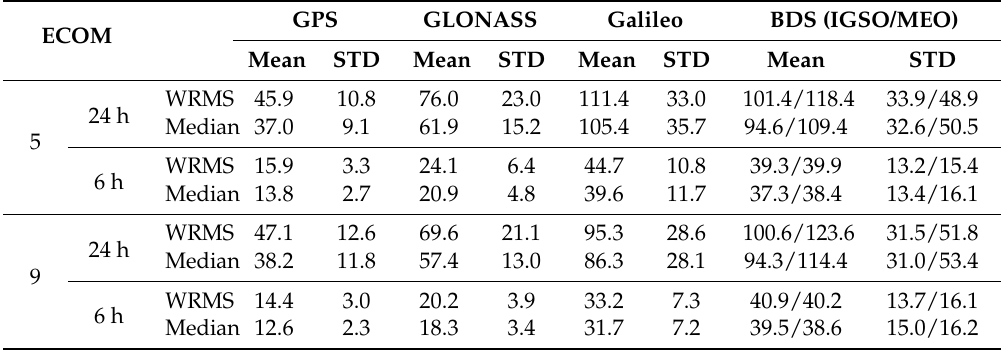
Table 3. Means and standard deviations (STDs) of weighted root-mean-square (WRMS) and median residuals of the selected fitted arc length (GPS: 40–45 h; GLONASS: 40–45 h; Galileo: 42–48 h; BeiDou inclined geo-synchronous orbit (IGSO): 40–50 h; BeiDou medium earth orbit (MEO): 42–54 h; unit: mm). GPS GLONASS Galileo BDS (IGSO/MEO) ECOM Mean STD